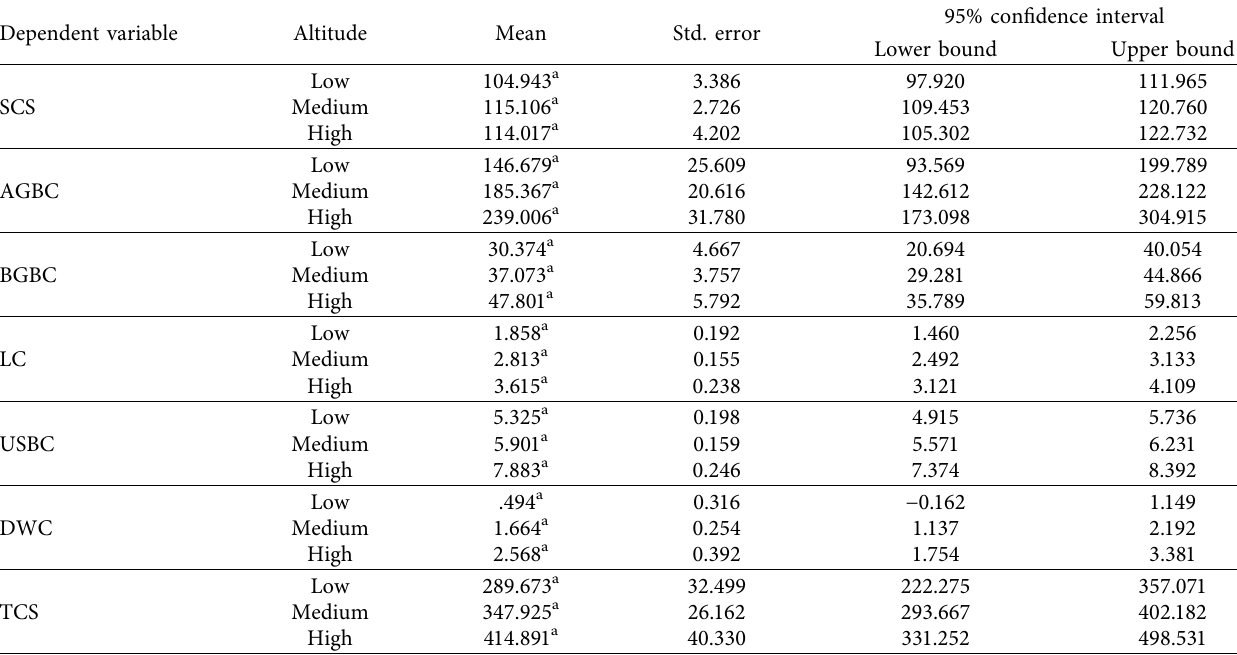
Table 8: Estimated marginal means of altitude in Anshirava